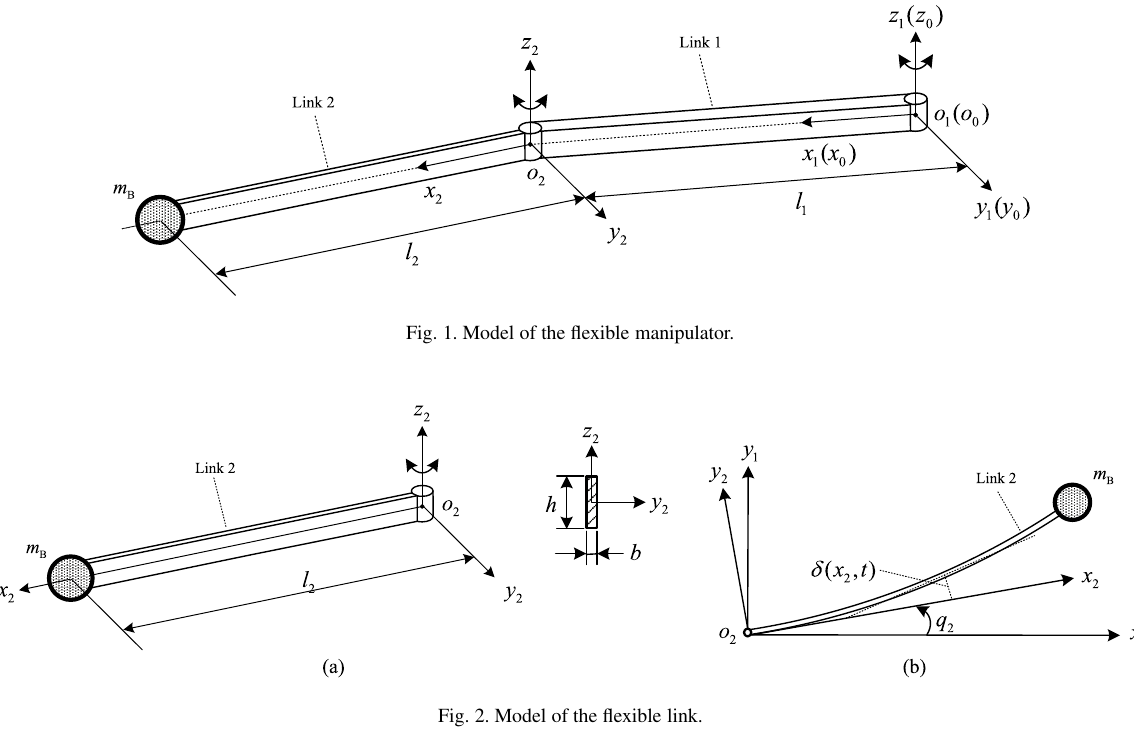
Fig. 2. Model of the flexible